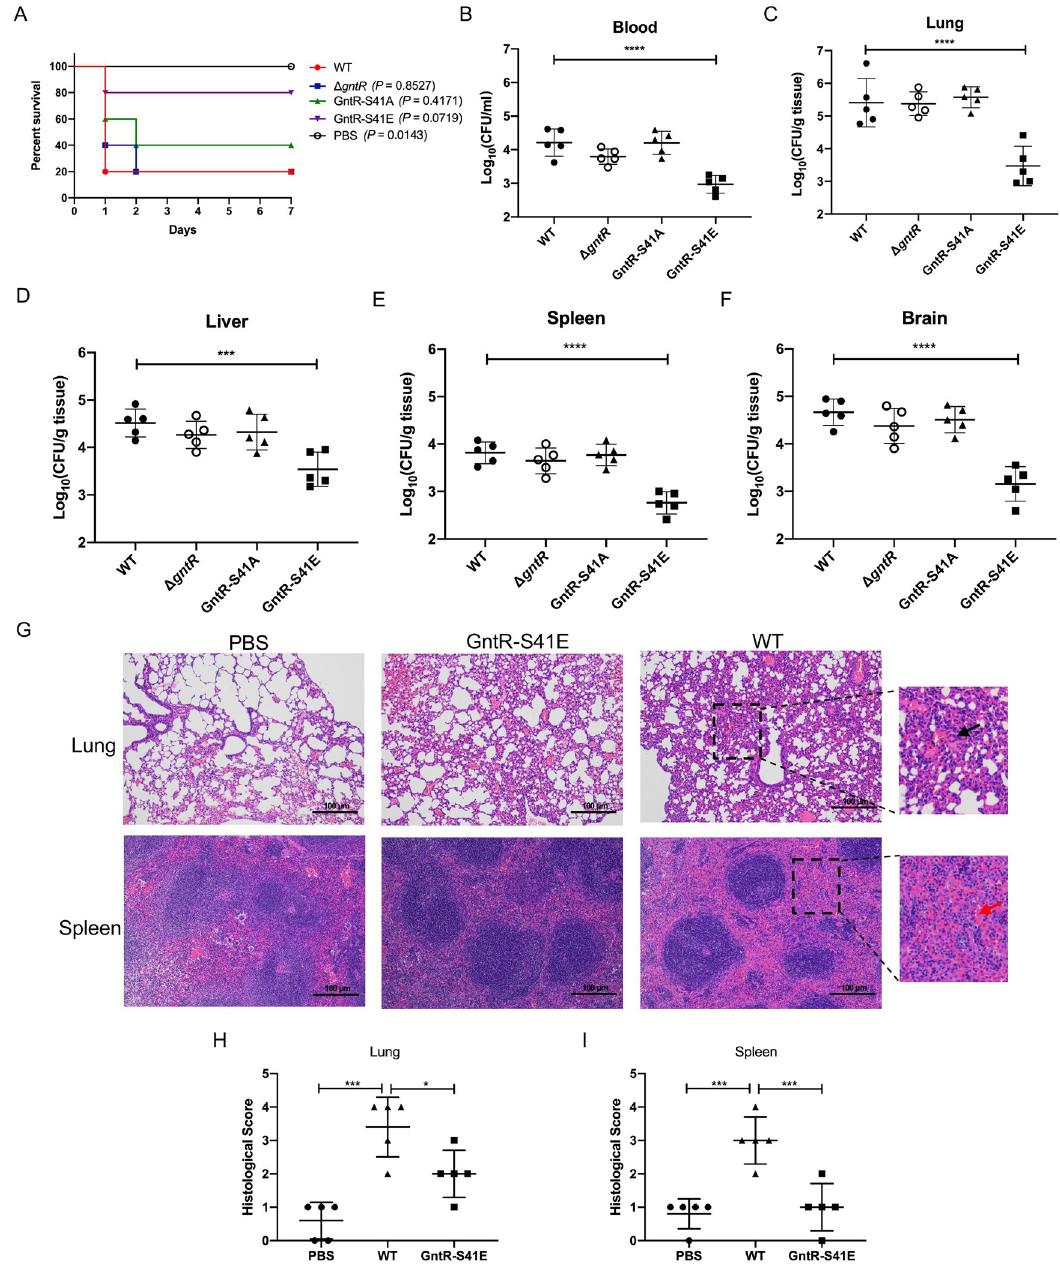
Fig 2. Phosphorylation of GntR reduced bacterial virulence. (A) BALB/c mice were challenged by intraperitoneal injection with WT SS2, Δ gntR , GntR-S41A, and GntR-S41E at a dose of 5 × 10 8 CFUs/mice (n = 5 mice/group), and the survival time was monitored. (B-F) Bacterial loads in the blood (B), lung (C), liver (D), spleen (E), and brain (F) of BALB/c mice challenged with 5 × 10 7 CFUs WT SS2, Δ gntR , GntR-S41A, and GntR-S41E by intraperitoneal injection at 24 hpi (n = 5 mice/group). (G) H&E staining of lung and spleen tissue sections from PBS, WT SS2, and GntR-S41E strain-infected mice by intraperitoneal injection at 24 hpi. In the enlarged area of the images (black dashed frame), the "black arrow" indicates alveolar congestion, collapse, and thickening. The "red arrow" indicates the decreased number of lymphocytes. Scale bar, 100 μ m. (H-I) Pathological analysis of lung (H) and spleen (I) by blinded assessment of H&E stained sections. Data were statistically analyzed using Long-rank (A) and One-way ANOVA (B-F, H-I). � , P < 0.05; ��� , P < 0.001; ���� , P < 0.0001.